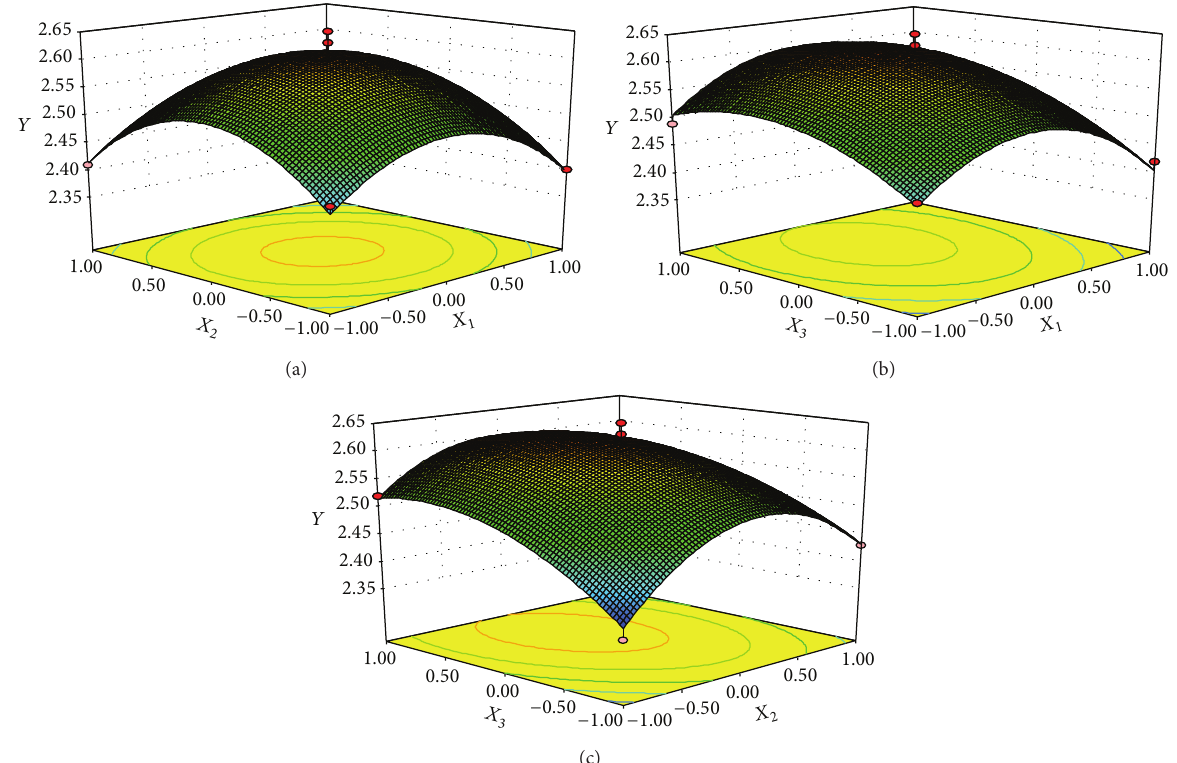
Figure 1: Response surface and contour plots for effect of independent parameters on extraction yield of the total flavonoids.